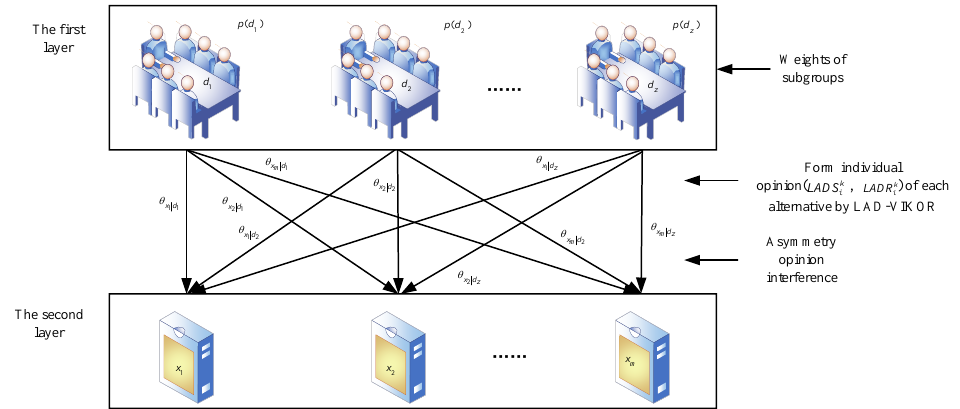
Figure 7. A quantum-based BN of a MAGCD problem.